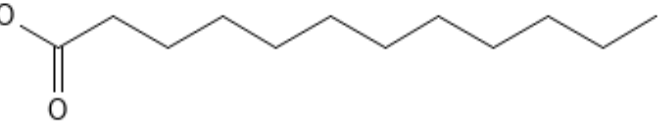
Figure 2. Lauric acid chemical structure, obtained with Draw Structure software by PubChem (https://pubchem.ncbi.nlm.nih.gov/#draw=true (accessed on 8 October 2021)). Myristic and palmitic